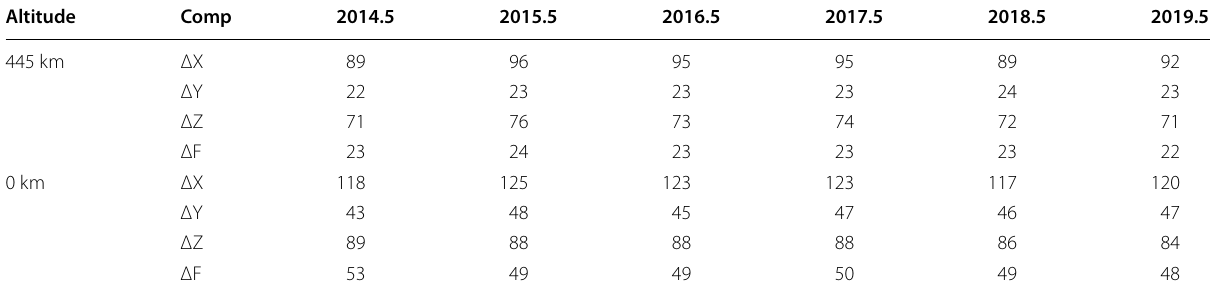
The rms values in the table are in nT